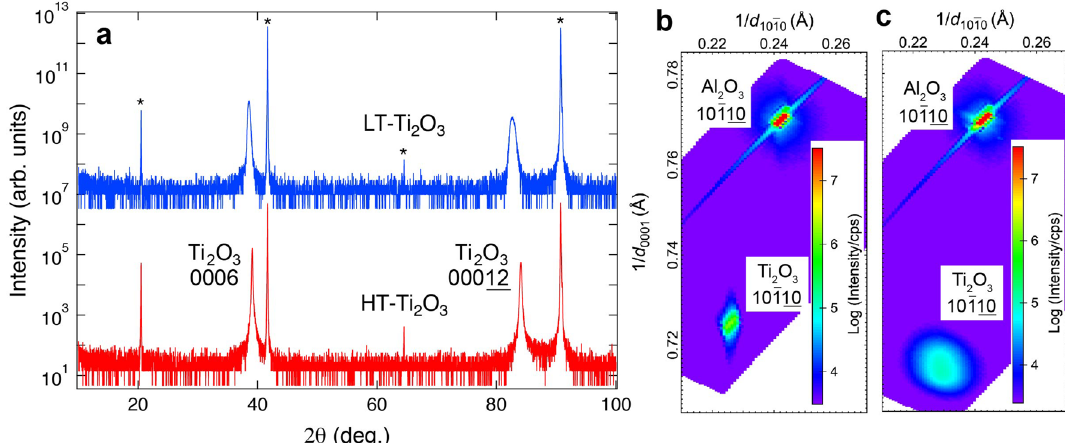
Figure 3. Determination of in-plane and out-of-plane lattice constants of the Ti 2 O 3 films. ( a ) Out-of-plane XRD patterns for the HT- and LT-Ti 2 O 3 films. The asterisks indicate the reflection coming from α -Al 2 O 3 (0001) substrates. Reciprocal space maps around α -Al 2 O 3 10-110 reciprocal points in the cases of the ( b ) HT- and ( c ) LT-Ti